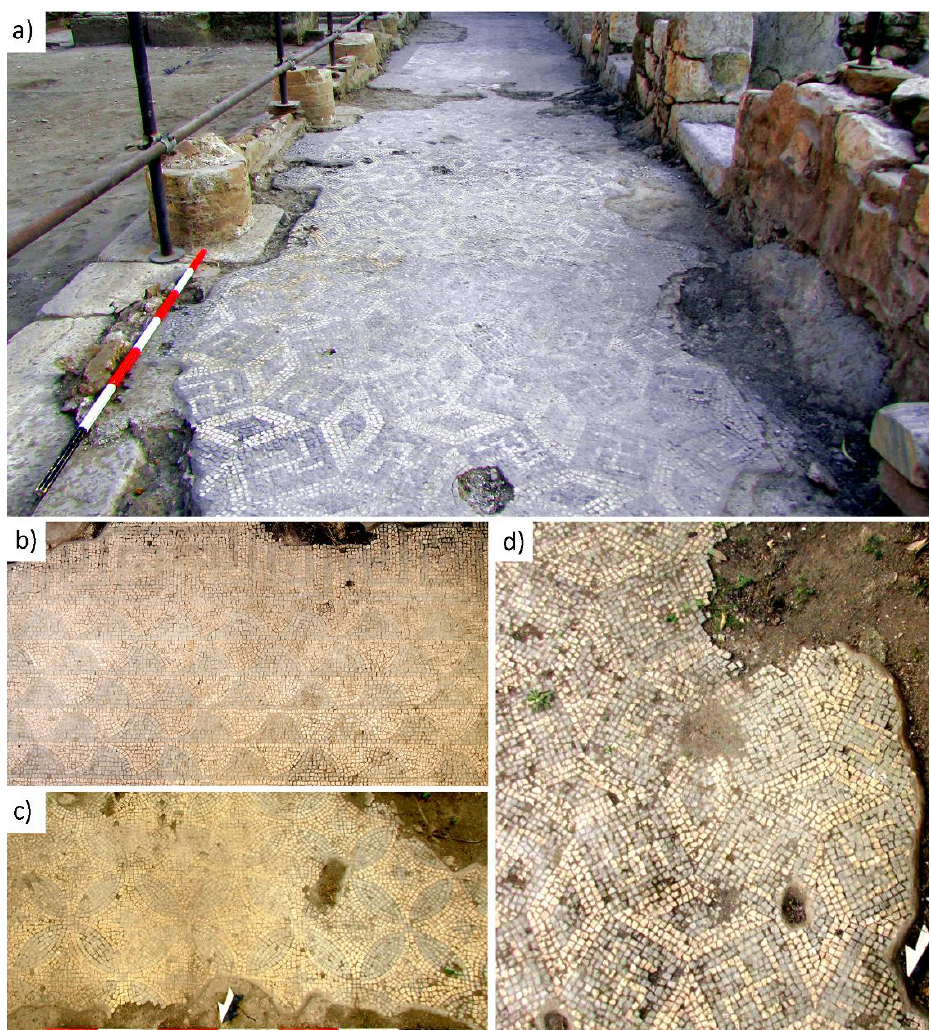
Figure 1. Domus 1; ( a ) the west ambulatory of the courtyard, view from the north; ( b – d ) geometric patterns of the black and white mosaics of the north, west and east ambulatories, respectively, around the courtyard.